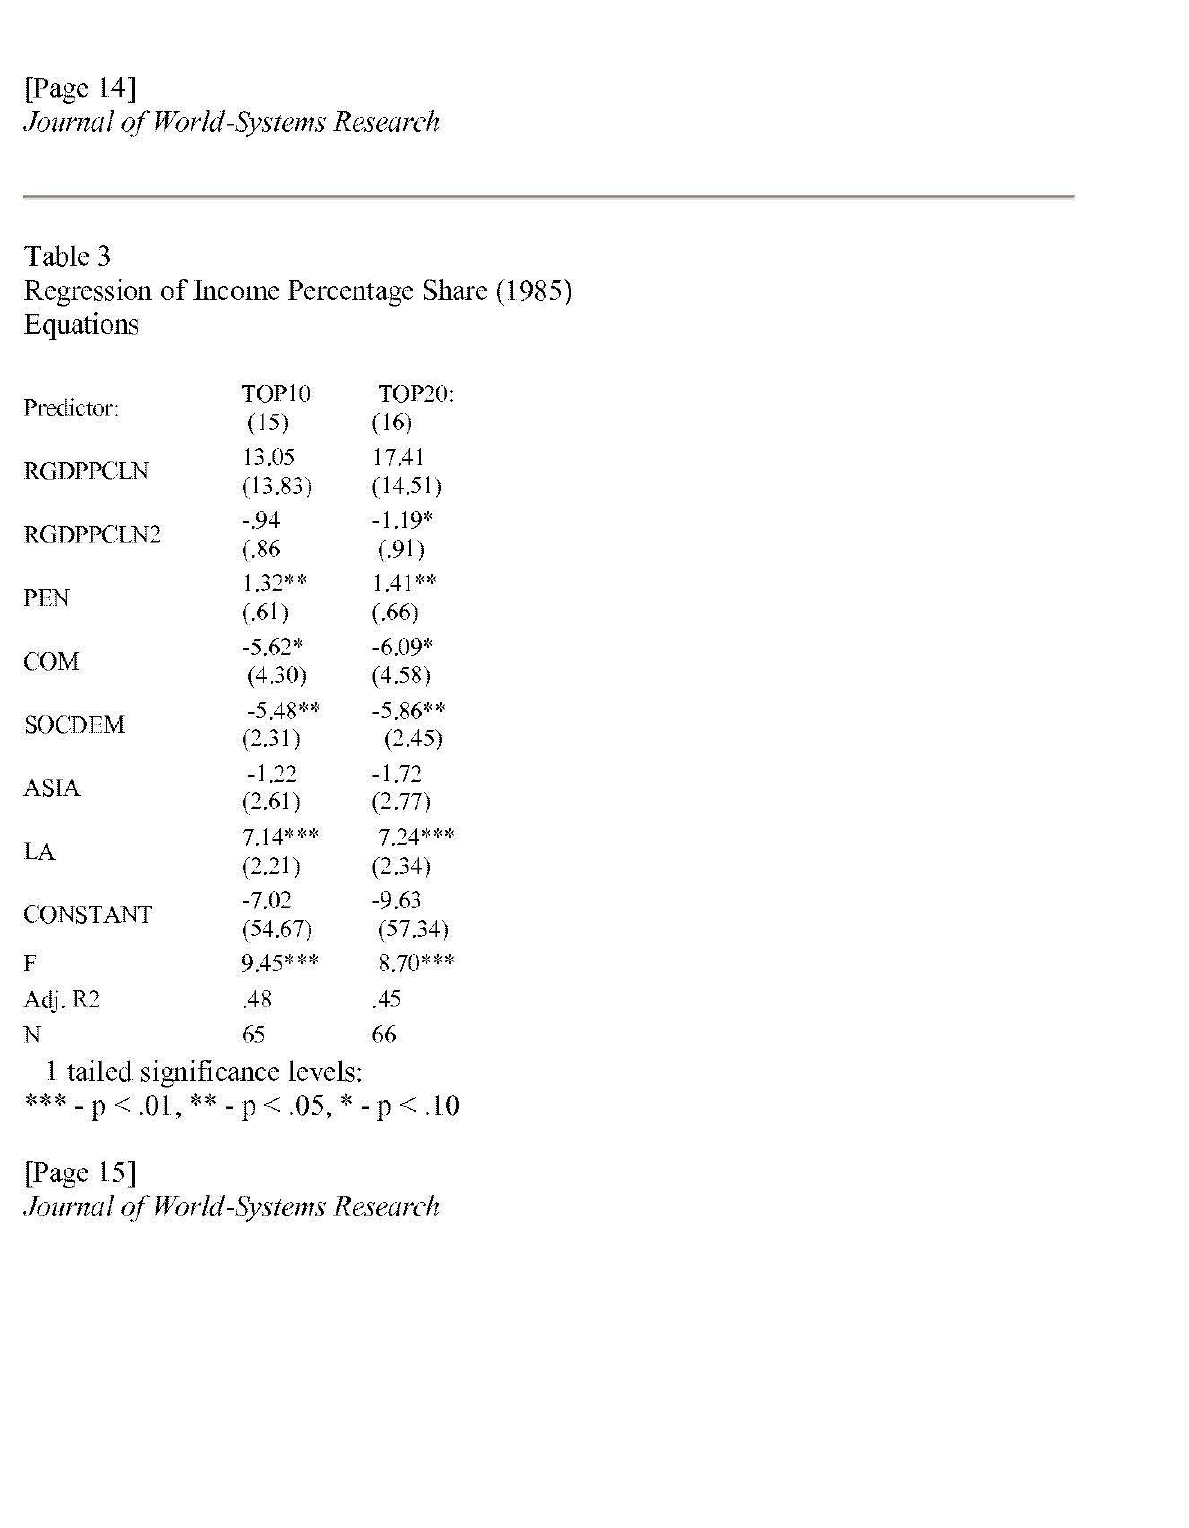
Regression of Income Percentage Share